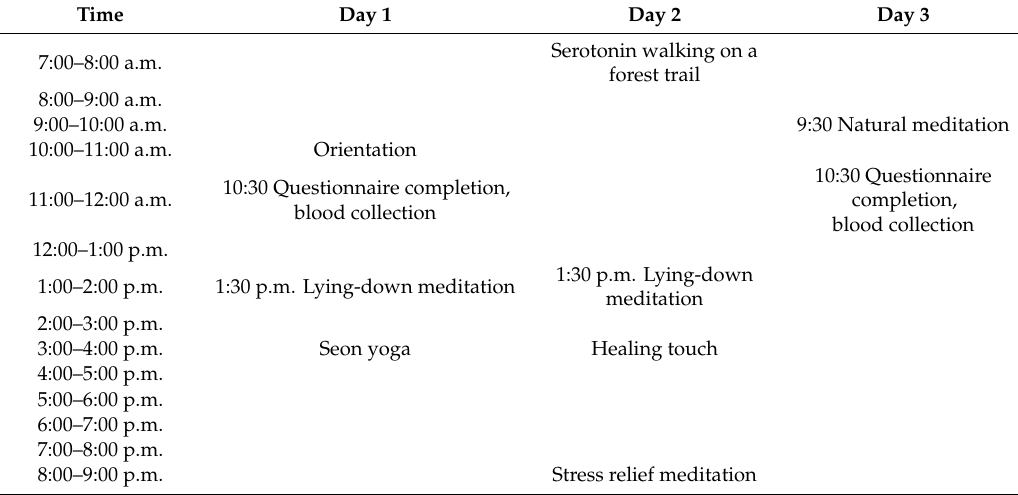
Table 2. Forest therapy program schedule for the forest (experimental)